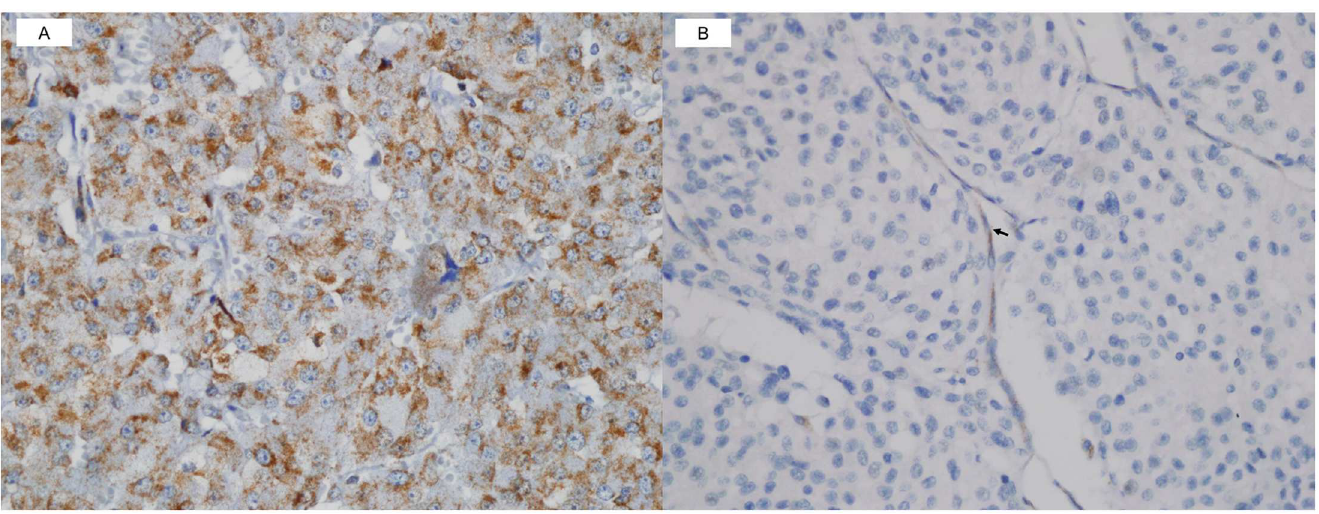
Fig 1. Immunohistochemical (IHC) staining of succinate dehydrogenase gene subunit B (SDHB). (A) Positive SDHB IHC staining with definite granularcytoplasmic staining(mitochondrial pattern) and (B) negativeSDHB IHC stainingwithout definitegranularcytoplasmic staining, in contrast to positive stainingin the internalcontrols such as endothelialcells (arrow) and sustentacularcells (SDHB IHC originalmagnification, × 400).